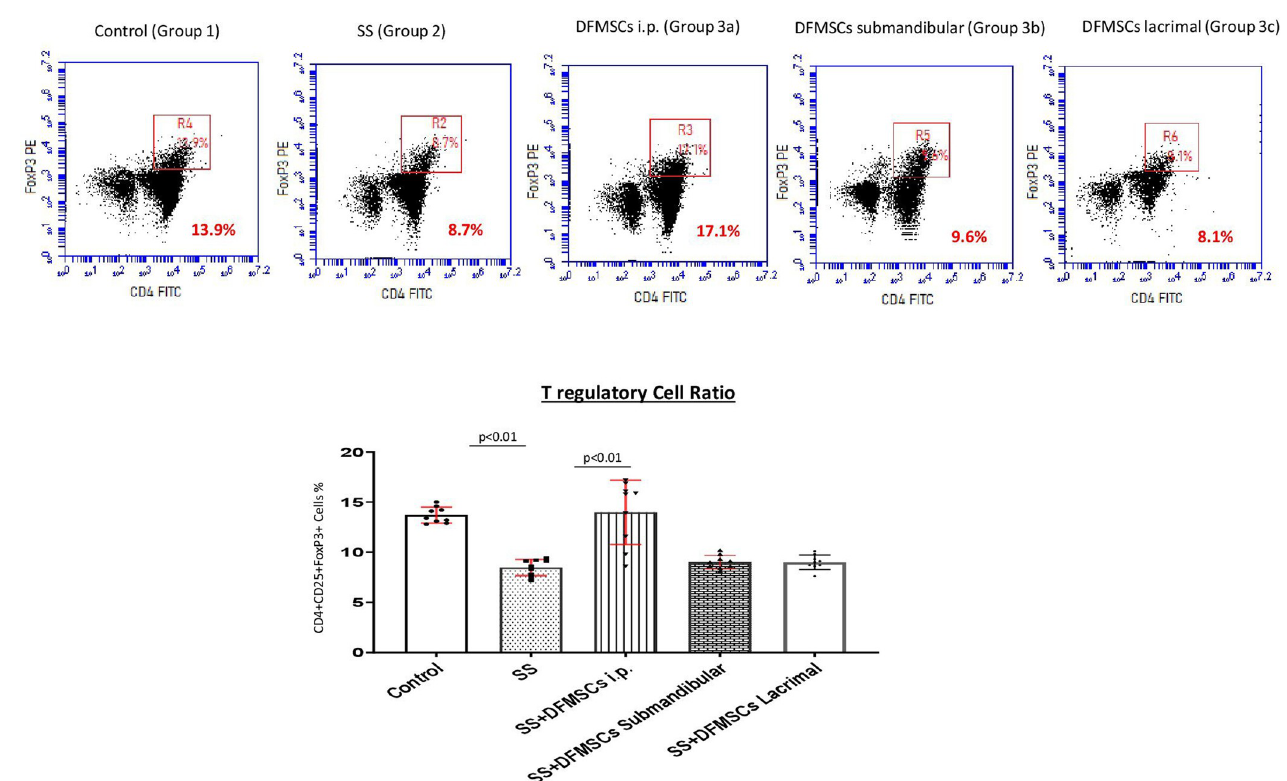
Fig 2. FoxP3 expressing T regulatory cell frequency. The intraperitoneal injection of DFMSCs significantly enhanced CD4+CD25+FoxP3+ T regulatory cell ratio compared to Group 2 (p < 0.01). FoxP3 expressing CD4+CD25+ T regulatory cell ratio in intraperitoneal injected DFMSCs group (Group 3a) was close to Group 1, and no significant difference was observed between two groups (p > 0.05). The submandibular and lacrimal injections of DFMSCs did not significantly change CD4+CD25+FoxP3+ T regulatory cell frequency compared to Group 2 (p > 0.05 and p > 0.05, respectively).